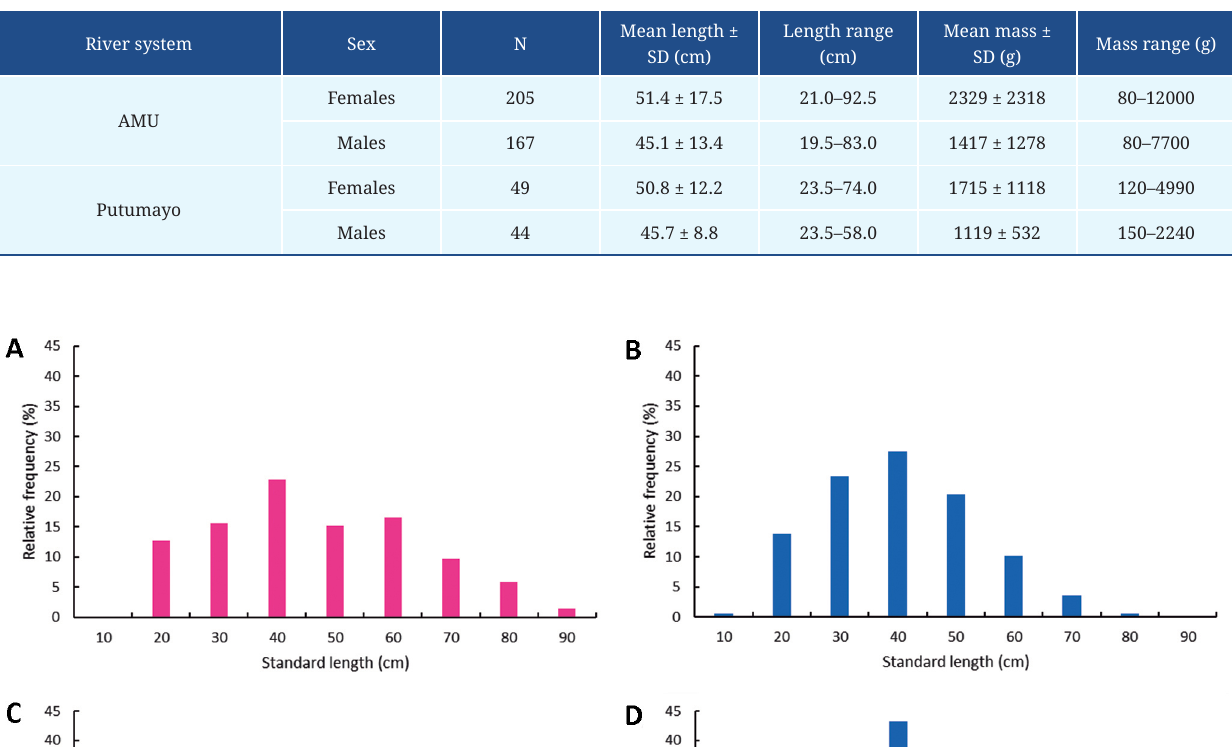
TABLE 1 | Standard length and mass ranges, mean ± standard deviation (SD) and number (N) of Pseudoplatystoma punctifer females and males analyzed in AMU system and Putumayo